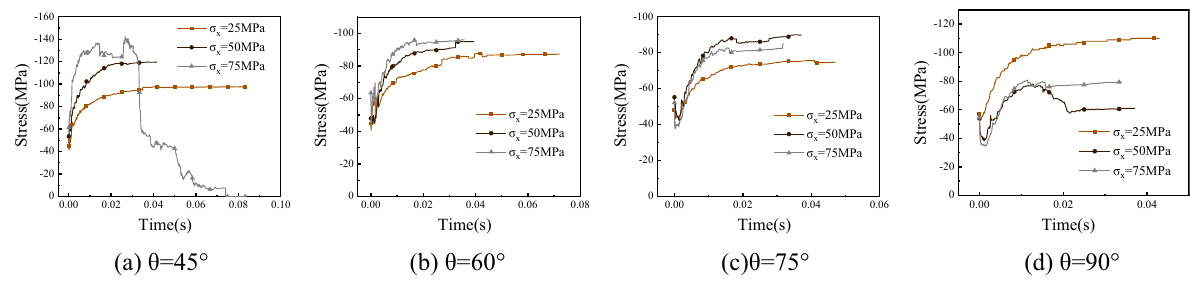
Fig. 27 Tangential stress with different σ x in the same inclined angles of joints (RQD = 80)